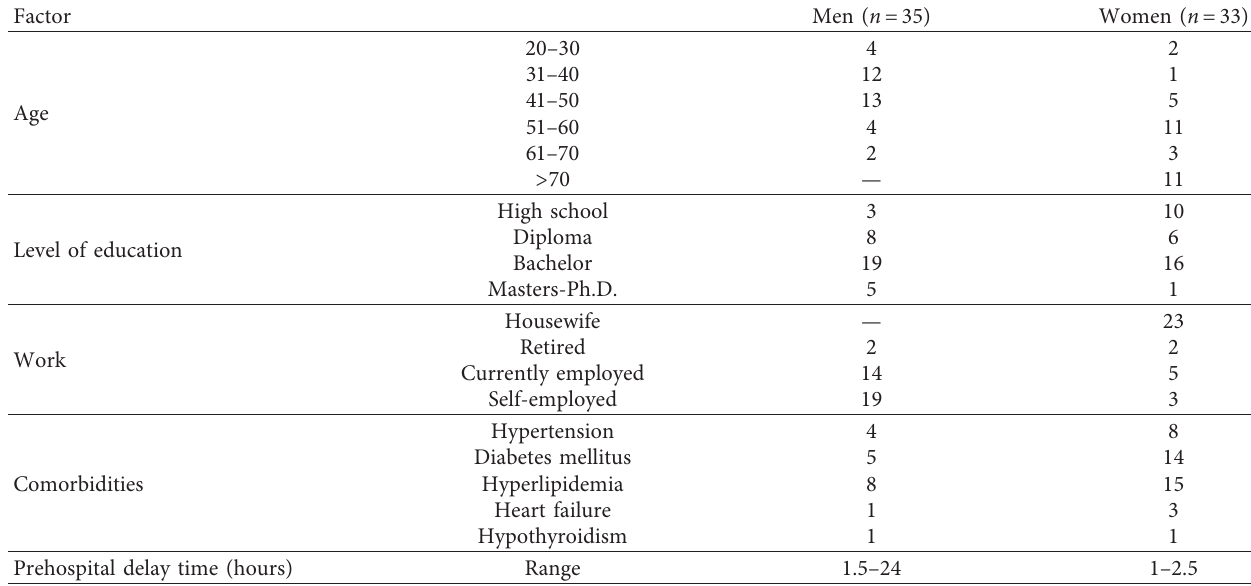
Table 1: Characteristics of the study sample ( n � 68).